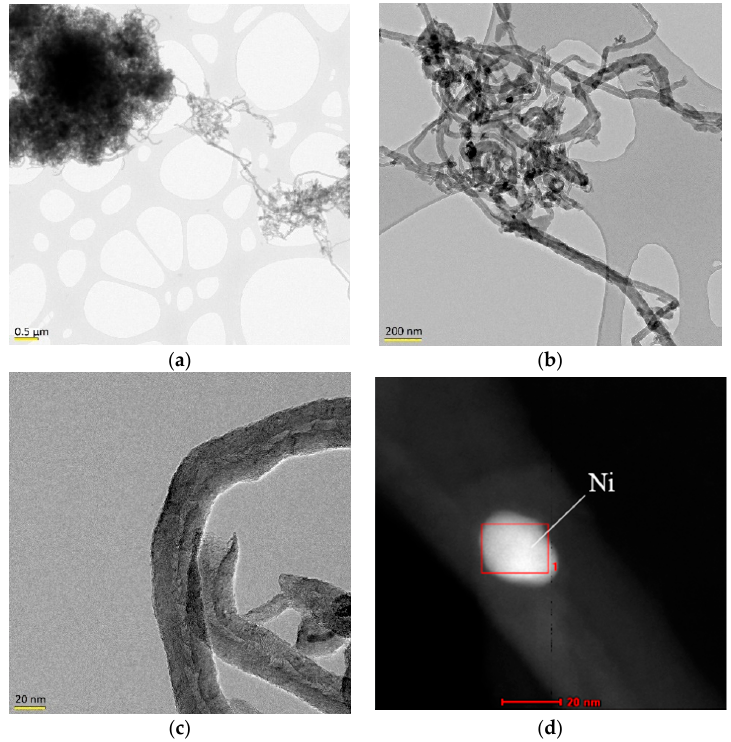
Figure 8. ( a - c ) Transmission electron microscopy (TEM); and ( d ) scanning transmission electron microscopy (STEM) images of carbon nanofibers (CNF) obtained on Ni/Al catalyst. CDM was carried out in a quartz FBR for 120 min with an operating temperature of 650 °C.